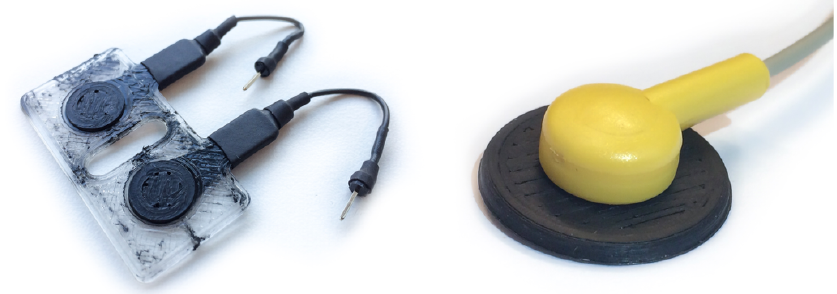
Figure 2. ( Left ): 3D-printed and assembled sensing structure (D10_IED20). ( Right ): Connected 3D-printed snap